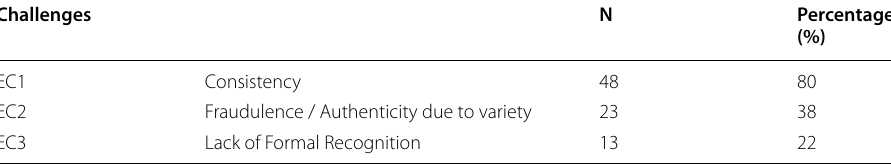
Table 4 Summary view of the challenges offered by micro-credentials for employers Challenges N Percentage